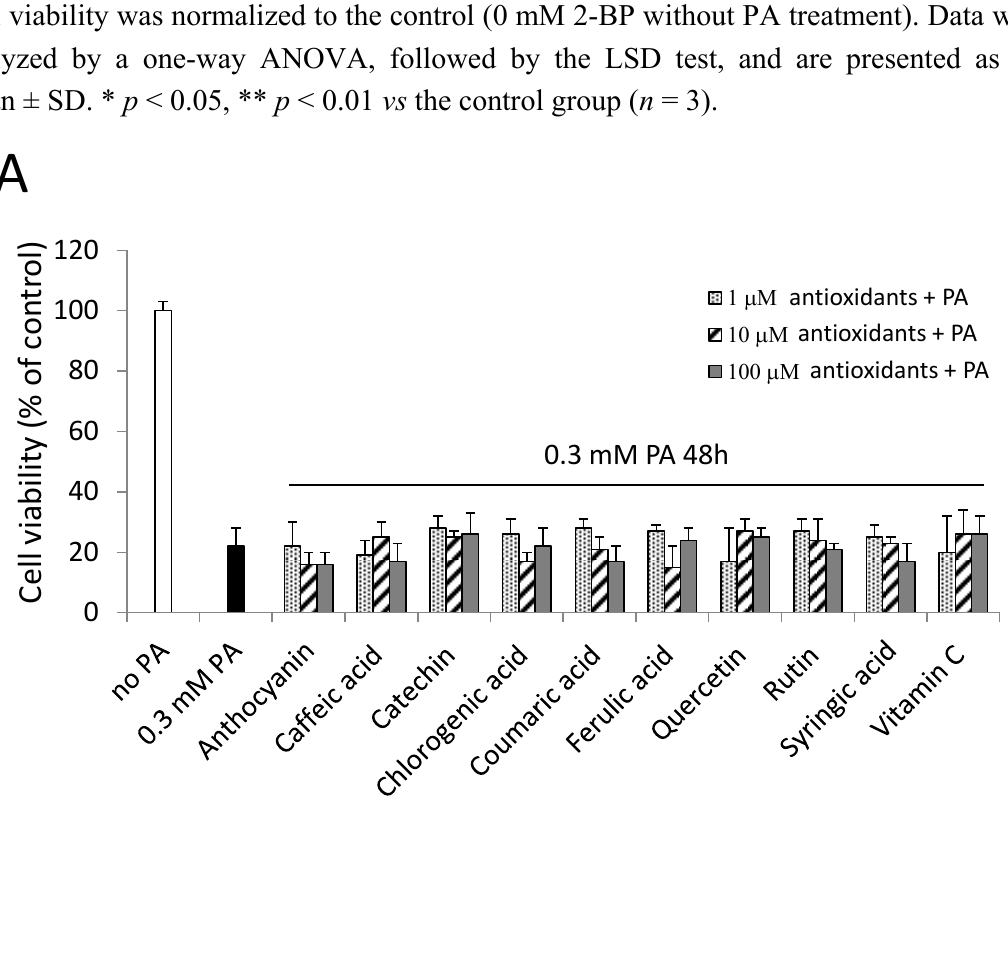
Figure 6. Effects of antioxidants, a protein kinase C (PKC) inhibitor (calphostin C; Calph) and a palmitoylation inhibitor (2-bromopalmitate; 2-BP) on PA-induced cell